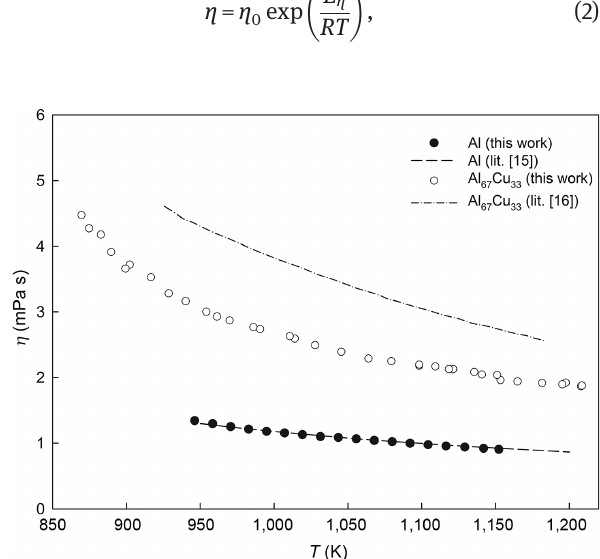
Figure 2: Temperature dependence of the viscosity for liquid Al and liquid Al 2 Cu